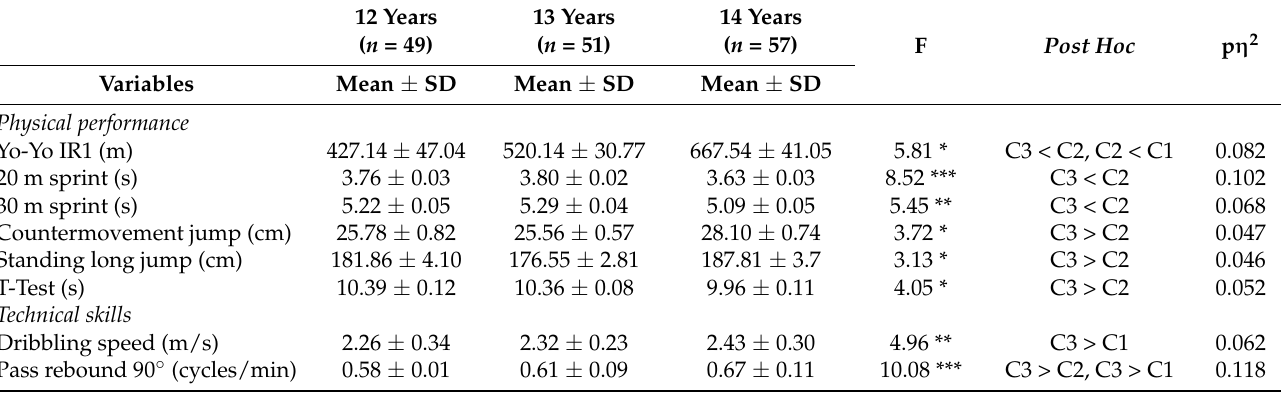
Table 6. Descriptive statistics [adjusted means and standard error (S.E.)] from ANCOVA (covariates: weekly formal soccer training sessions, and biological maturation) of young soccer